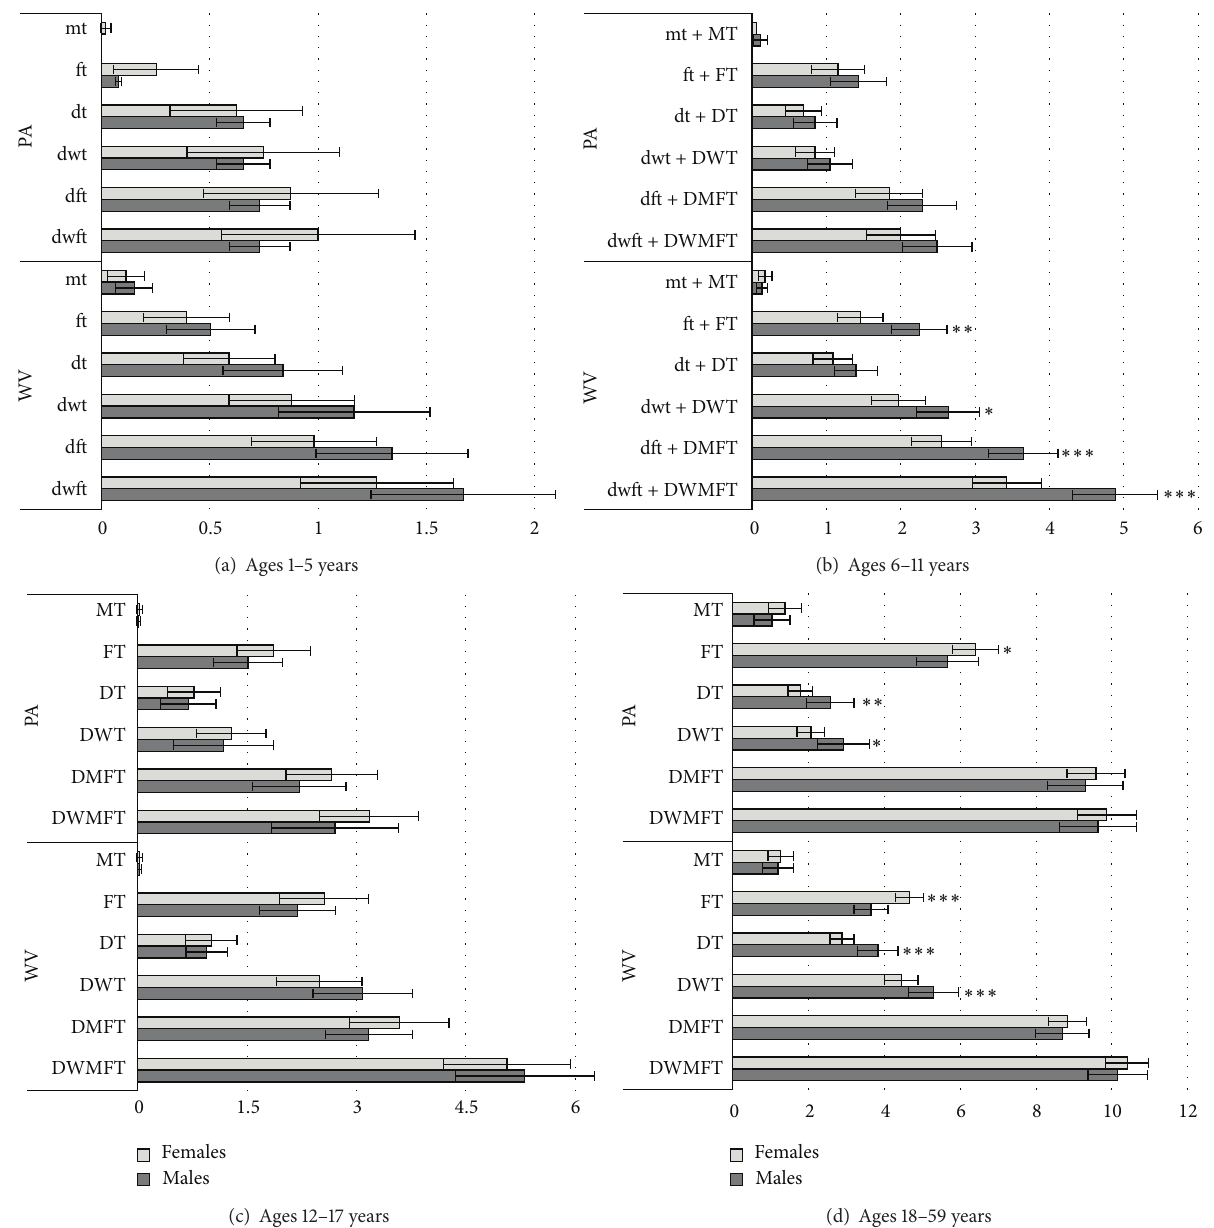
Figure 2: Mean dental caries indices by sex for (a) primary dentition in children aged 1–5 years, (b) mixed dentition in children aged 6–11 years, (c) permanent dentition in adolescents aged 12–17 years, and (d) permanent dentition in adults aged 18–59 years. Error bars represent 95% confidence intervals around the unadjusted means. Significant sex differences are indicated as follows: ∗ 𝑝 value < 0.05; ∗∗ 𝑝 value < 0.01; ∗∗∗ 𝑝 value < 0.001. Note: sex differences were tested while simultaneously adjusting for age; therefore, significant 𝑝 values may be indicated for some caries indices where 95% confidence intervals appear to